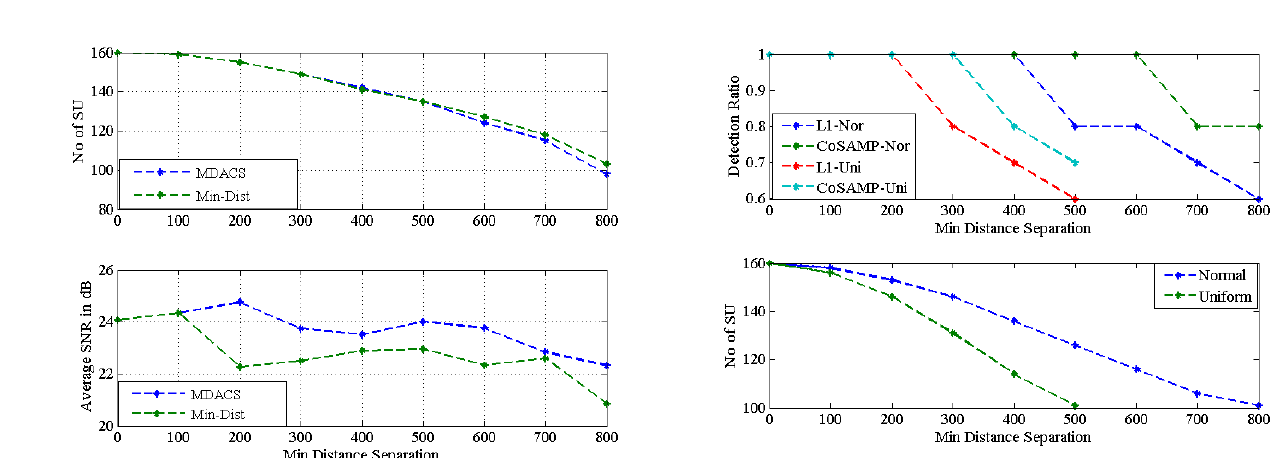
Figure 7. (a) No of SU vs minimum distance separation (b) Average received SNR vs minimum distance separation.